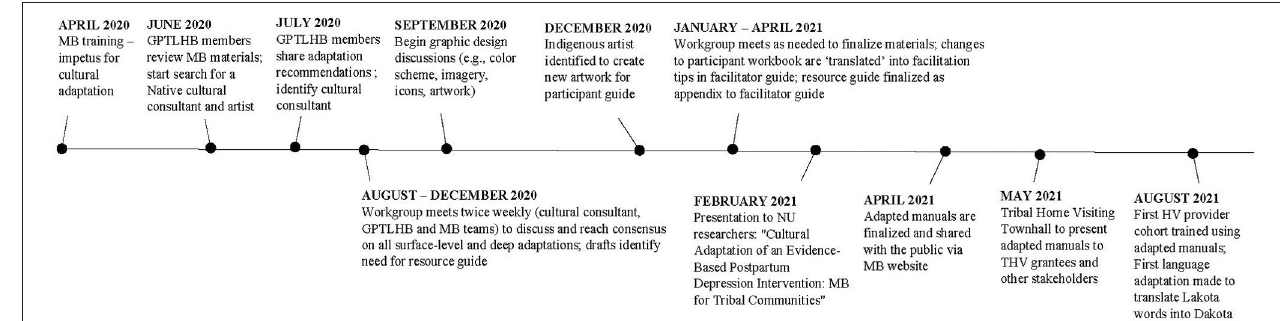
FIGURE 1 | Timeline of cultural adaptation workgroup process and dissemination to